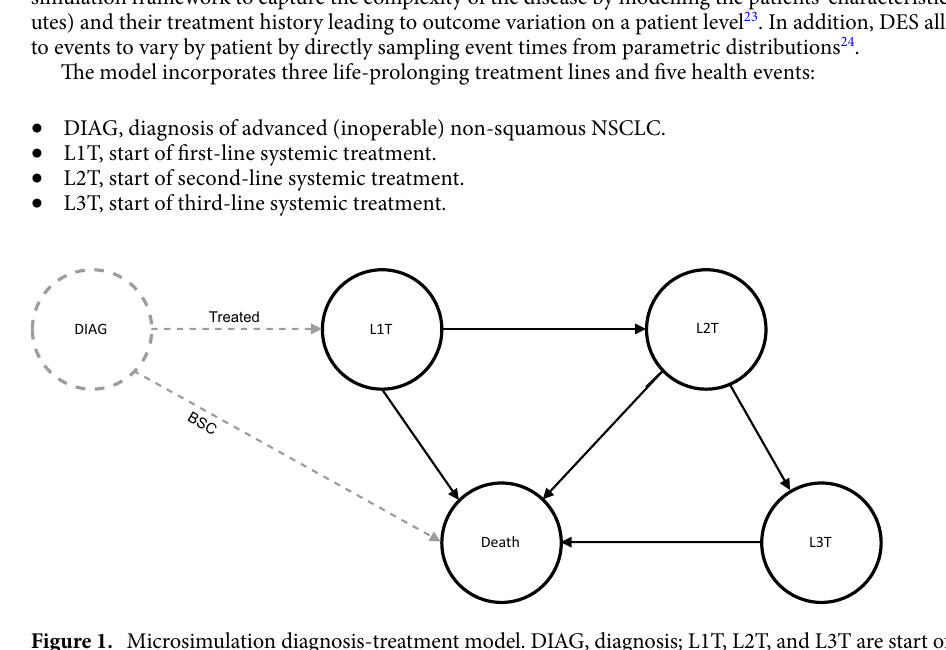
Figure 1. Microsimulation diagnosis-treatment model. DIAG, diagnosis; L1T, L2T, and L3T are start of first-, second-, and third-line treatment, respectively; BSC, best supportive care, i.e., patients who are ineligible for L1T; Treated, patients who started at least one line of systemic treatment. Arrows indicate the possible transitions from one event to the start of a next treatment line or death. Black circles and lines denote the disease trajectory after treatment initiation. The corresponding time to event distributions were modelled as a parametric multistate statistical model (parMSSM). Gray dotted circle and lines denote the trajectory from DIAG to either start of treatment or death. Time-to-events from DIAG to L1T and from DIAG to death were not part of